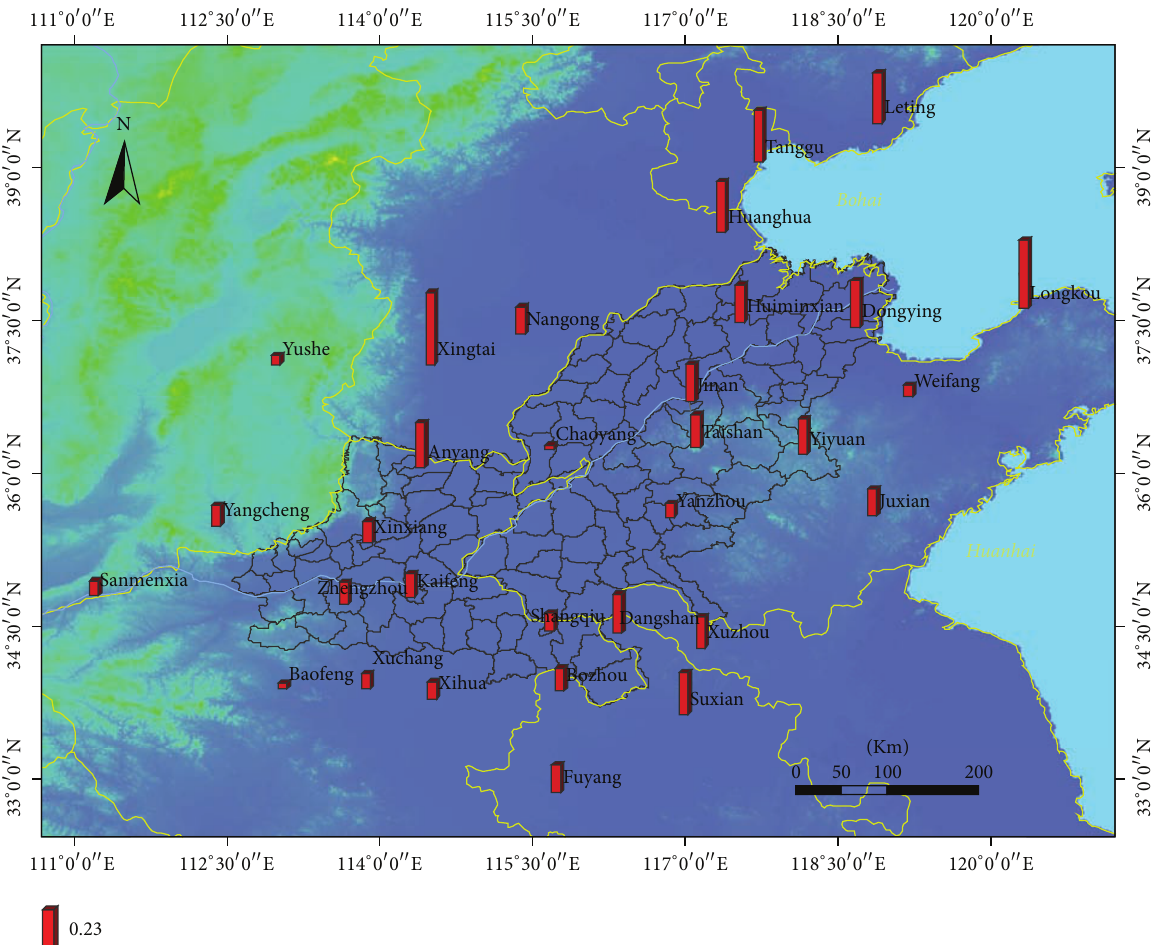
Figure 3: Trend rates of temperature change at meteorological stations in the Lower Yellow River Region from 1960 to 2001 (unit of measurement ∘ C/10